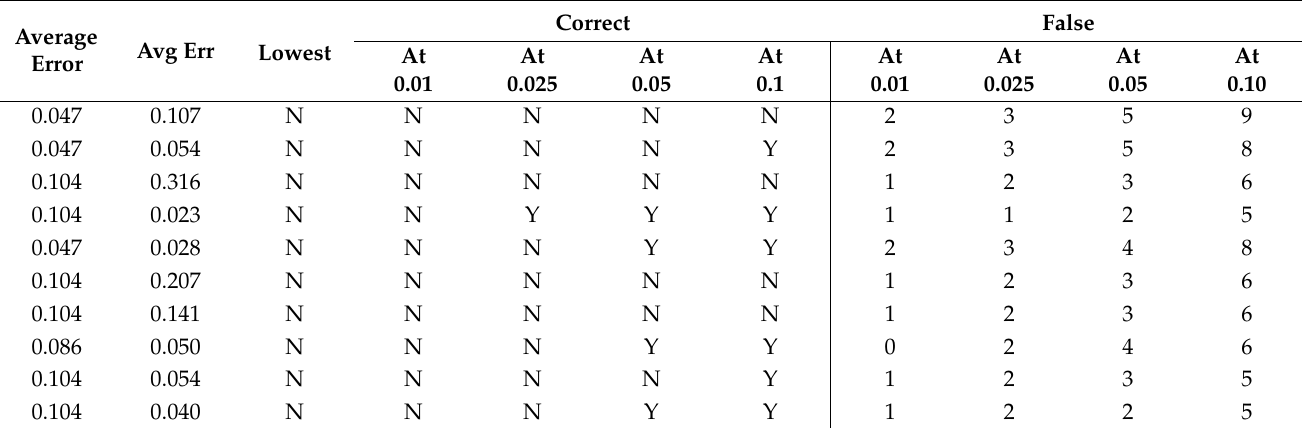
Table A170. Set 3, trials 1–10 summary data (all 0.5 PR values).